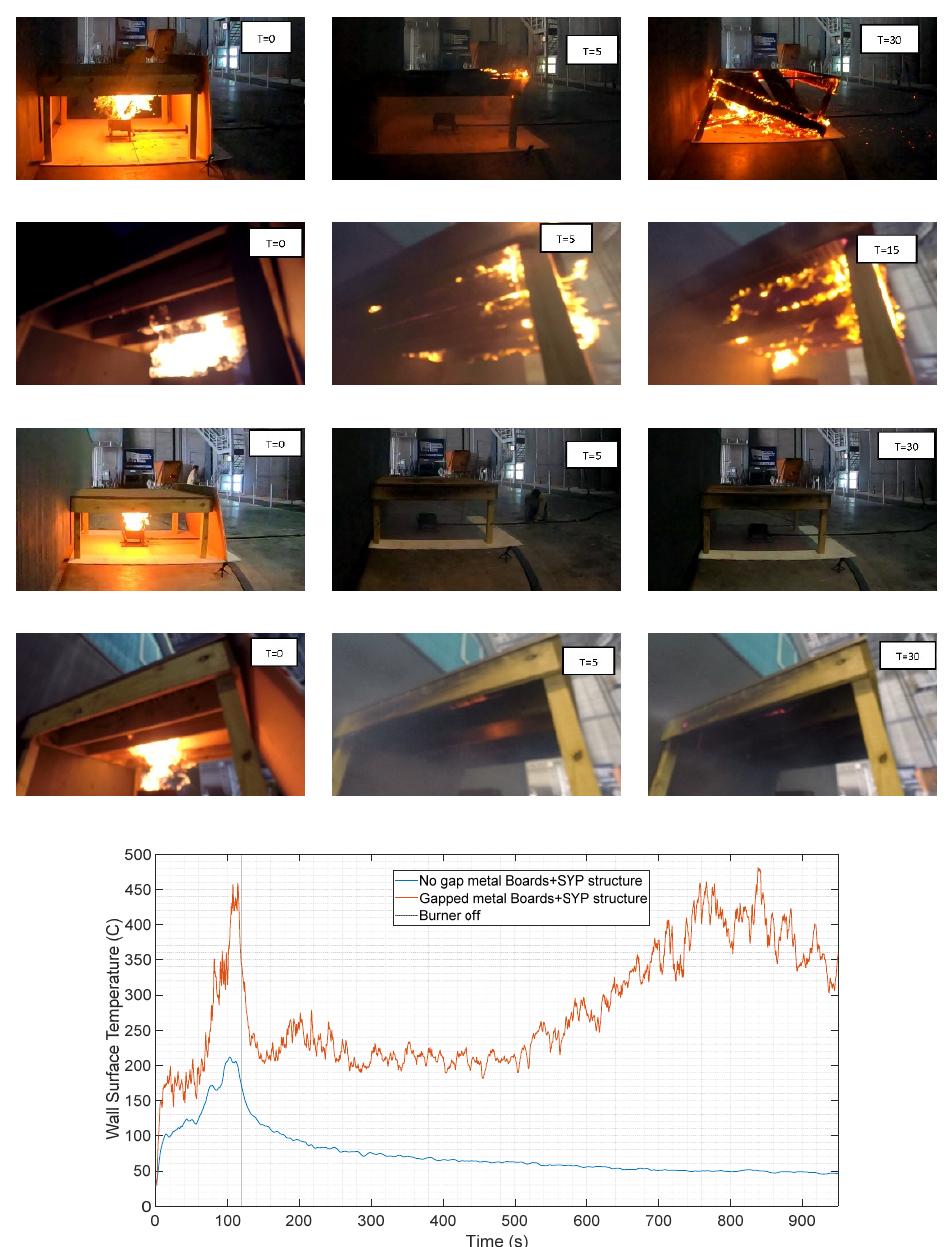
Figure 20. Time-lapse of two types of metal boards installed over SYP supporting system, ( First Row ) gapped metal boards, and ( Second Row ) no-gap metal boards, and the wall temperature.